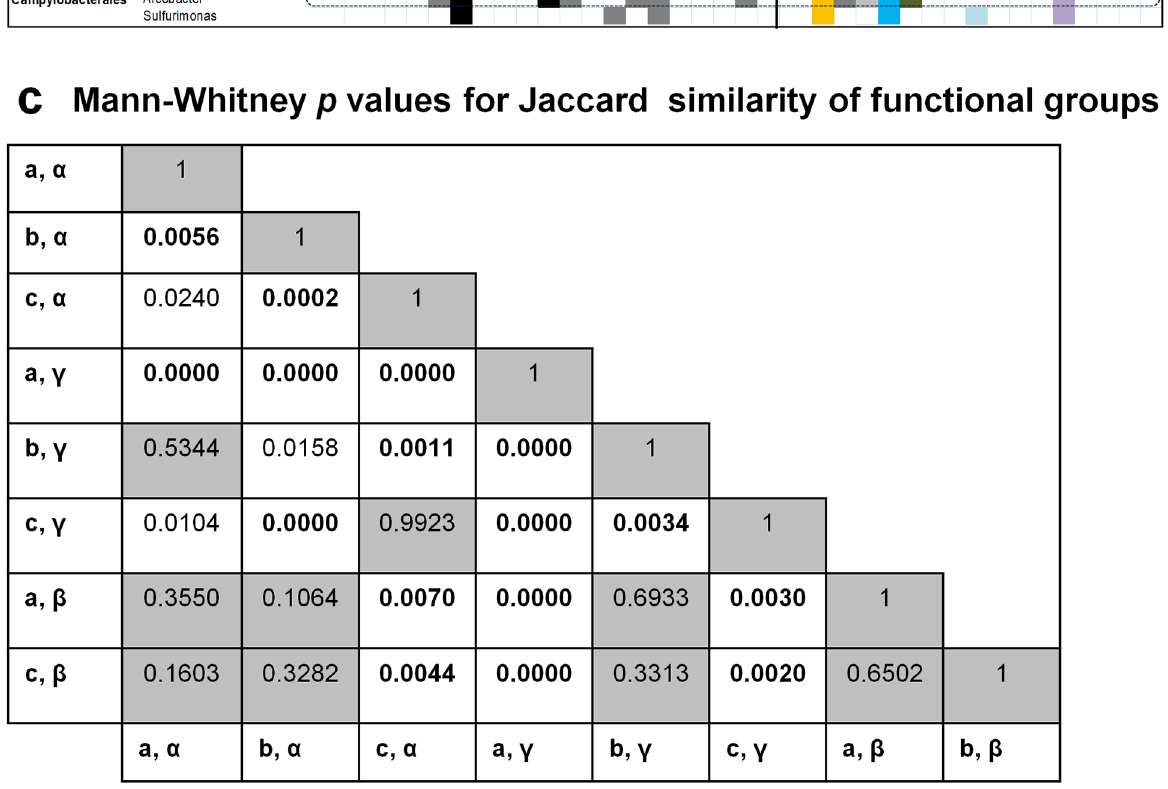
Fig 4. Visualization of the taxonomic distribution and metabolic traits of delta and epsilon proteobacteria and cross comparison of functional groups. Taxa of delta and epsilonproteobacteria in the microbiomeof soils and invertebrateswere